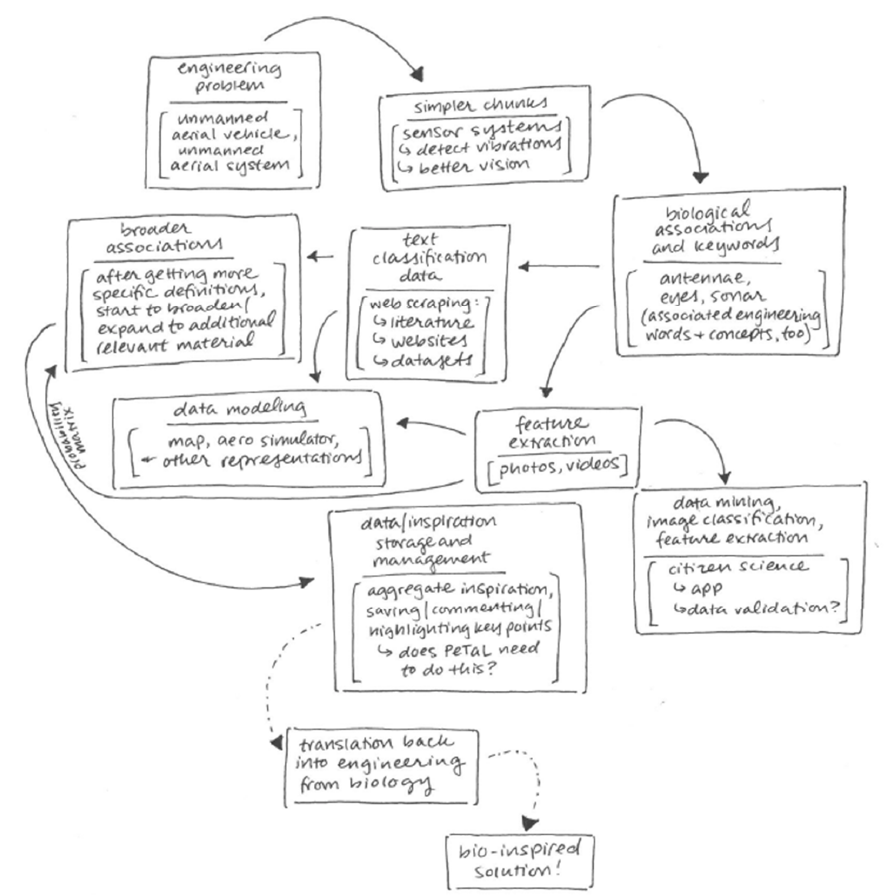
Figure 21. Sketch of possible workflow in PeTaL.